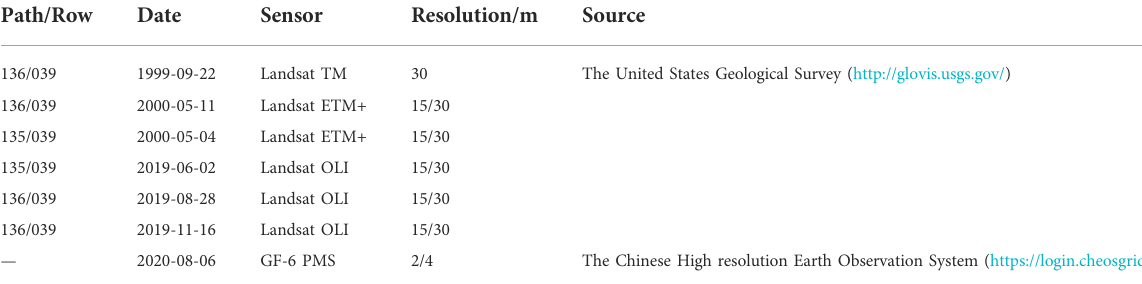
TABLE 1 Remote sensing images used in this